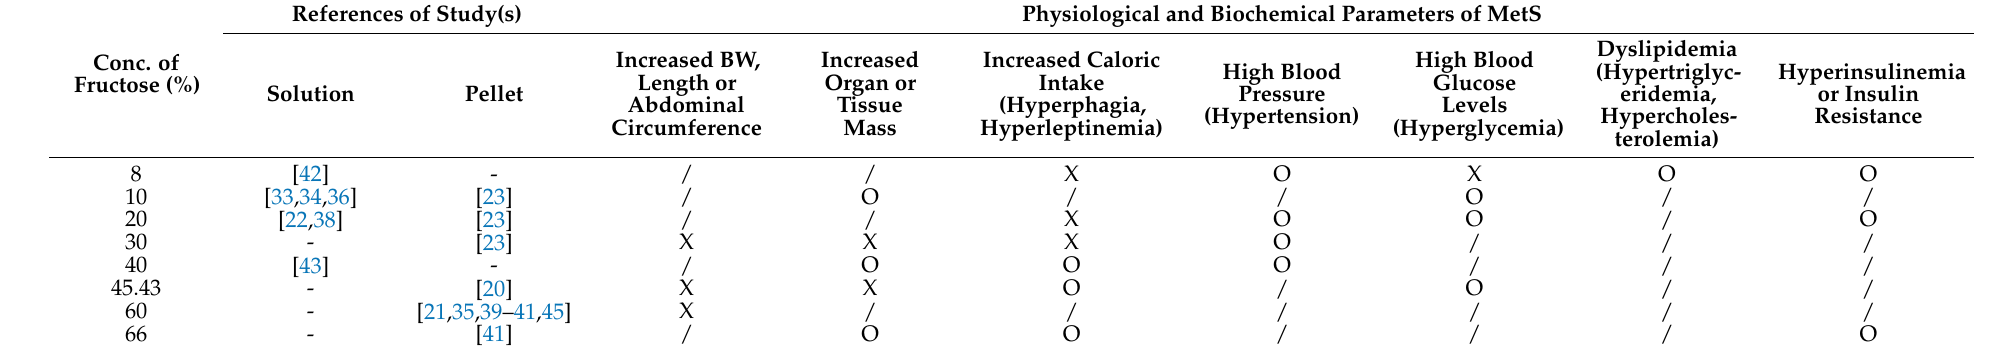
Table 4. Concentration of types of fructose diet to physiological and biochemical outcomes of